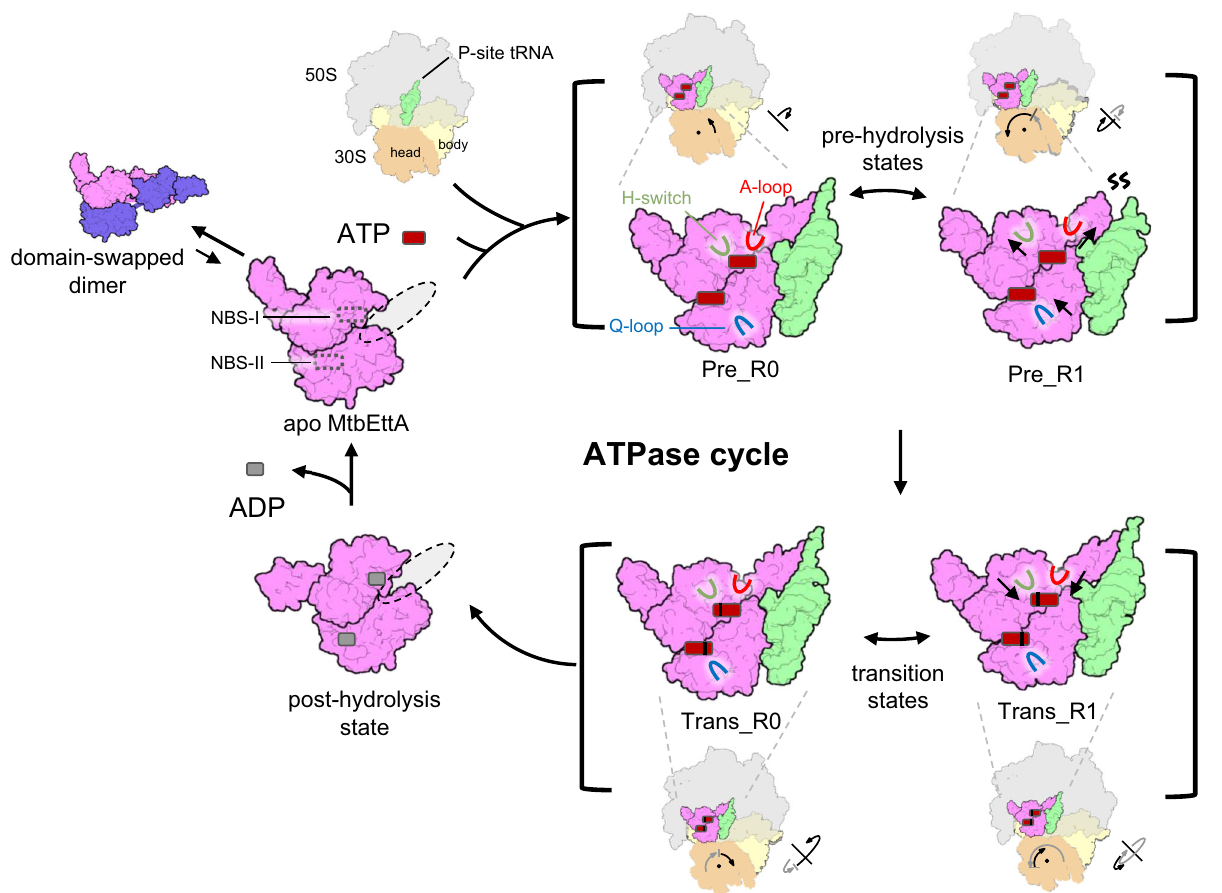
Fig. 7 Schematic model for the functional cycle of MtbEttA in the course of ATP hydrolysis. The monomer formation involves dissociation of the domain-swapped dimer (the favored con fi guration in solution) and rearrangement of the two NBDs to form a compact but open conformation. The monomeric MtbEttA transits to the closed conformation after binding to the E-site of the 70SIC in the presence of ATP molecules. At the pre-hydrolysis stage, the engagement of the Q-loop at NBS-II requires conformational change of the H-switch and A-loop in NBS-I, which is mediated by the bending of PtIM α 1 along with the 30S rotation. In addition, the tip of PtIM and the CCA tail of tRNA become distorted. Meanwhile, remodeling of the 50S occurs as a result of the occupancy of MtbEttA at the E-site and the intermediate rotation of 30S. In the transition state, MtbEttA and the P-site tRNA maintain stable interactions due to a more restricted 30S movement. The head swiveling and body rotation of 30S are indicated with arrows for the movement in the previous (gray arrows) and current (black arrows) steps, respectively, in a sequence of nonrotated, Pre_R0, Pre_R1, Trans_R1, and Trans_R0 states. At the post-hydrolysis stage, MtbEttA adopts an open conformation and disassociates from the ribosome. ADP dissociation and ATP reloading are necessary for the next